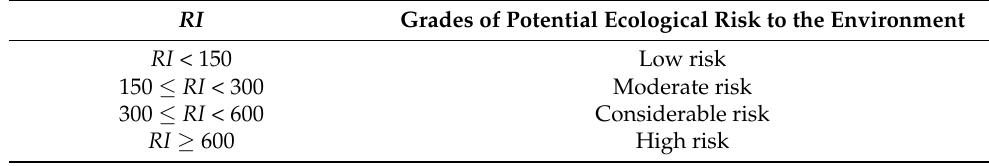
Table 1. Grading standards of potential ecological